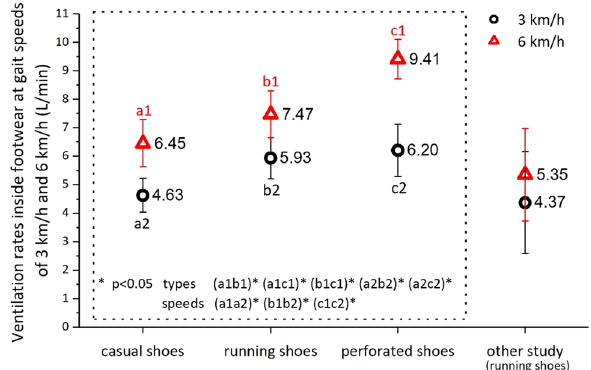
Figure 5. Ventilation rates inside footwear at gait speeds of 3 km/h and 6 km/h for three footwear types separately (Mean ± SD). Results of the “other study” refer to Yasuhiro et al. (2016) 14